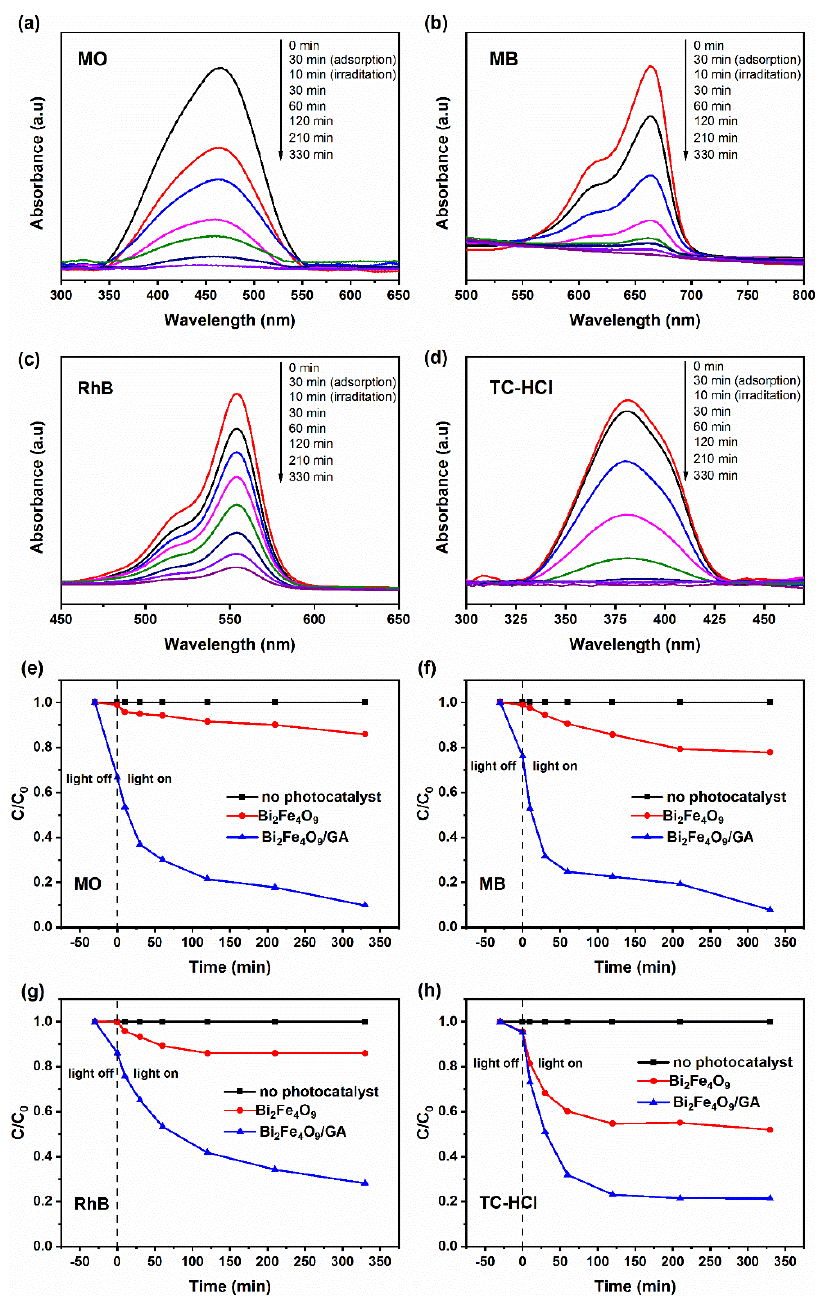
Figure 4. UV-visible spectra for photocatalytic degradation and photodegradation activity of ( a , e ) MO, ( b , f ) MB, ( c , g ) RhB and ( d , h ) TC-HCl catalyzed by Bi 2 Fe 4 O 9 /GA under visible light